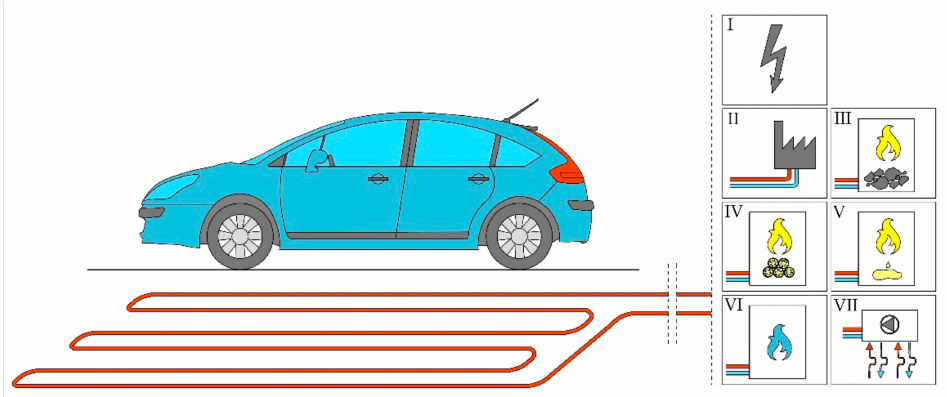
Figure 2. Schematic diagram of parking lot heating with: I—electricity, II—district heating network, III—hard coal boiler, IV—biomass boiler, V—fuel oil boiler, VI—condensing gas boiler, VII—heat pump with ground heat